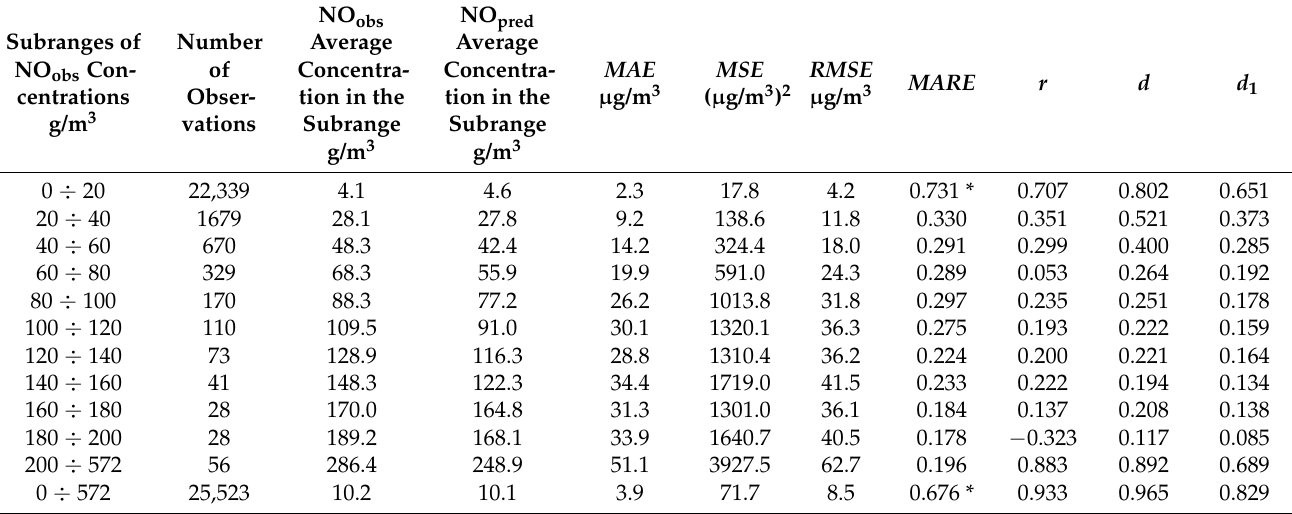
* cases with NO obs = 0 were removed to calculate MARE